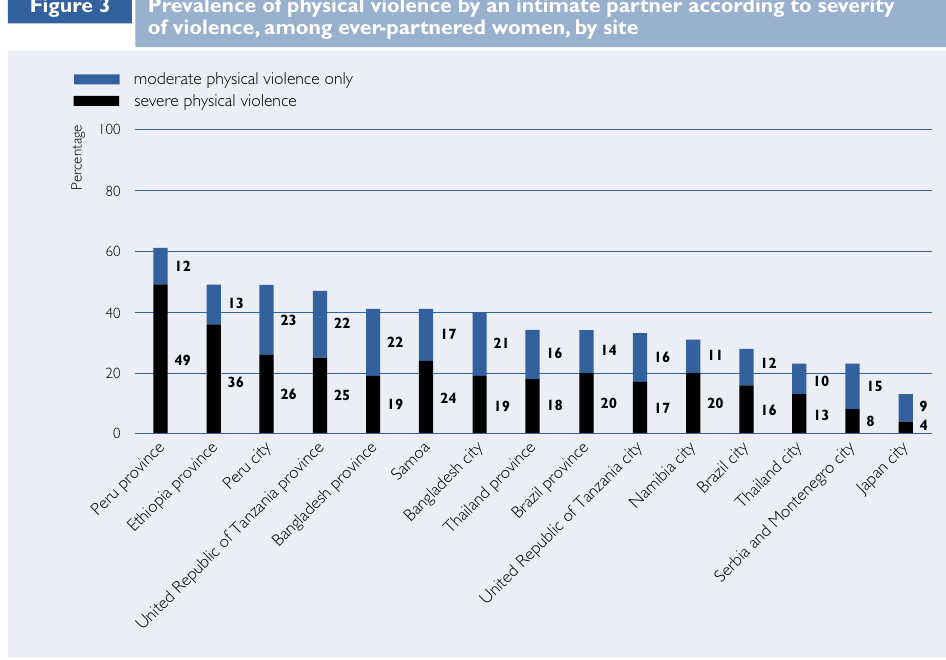
Figure 3 Prevalence of physical violence by an intimate partner according to severity of violence, among ever-partnered women, by